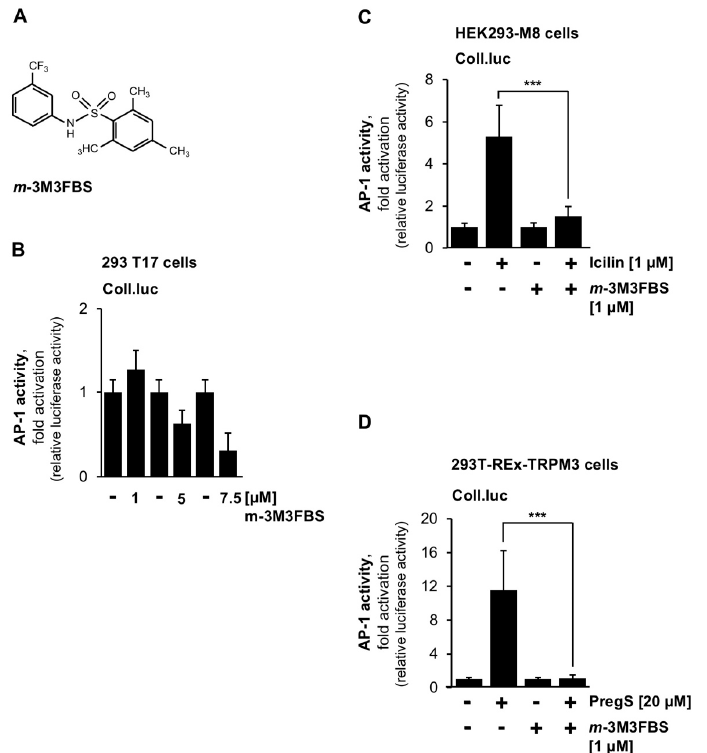
Figure 7. The compound m -3M3FBS blocks intracellular signaling mediated by TRPM8 and TRPM3. ( A ) Chemical structure of m -3M3FBS. ( B ) HEK293 cells containing the Coll.luc reporter gene were incubated with different concentrations of m -3M3FBS for 24 h. Cells were harvested and analyzed as described in the legend to Figure 1 (n = 3). ( C ) HEK293-M8 cells were infected with a recombinant lentivirus containing the Coll.luc reporter gene. Cells were serum-starved for 24 h, preincubated for 3 h with m -3M3FBS (5 µ M), and then stimulated with icilin (1 µ M). Cells were harvested and analyzed as described in the legend to Figure 1 (n = 3; *** p < 0.001). ( D ) T-REx-TRPM3 cells were (Coll.luc). Cells were serum-starved for 24 h in the presence of tetracycline (1 µ g/mL) to induce TRPM3 expression. Cells were preincubated for 3 h with m -3M3FBS (5 µ M) and then stimulated